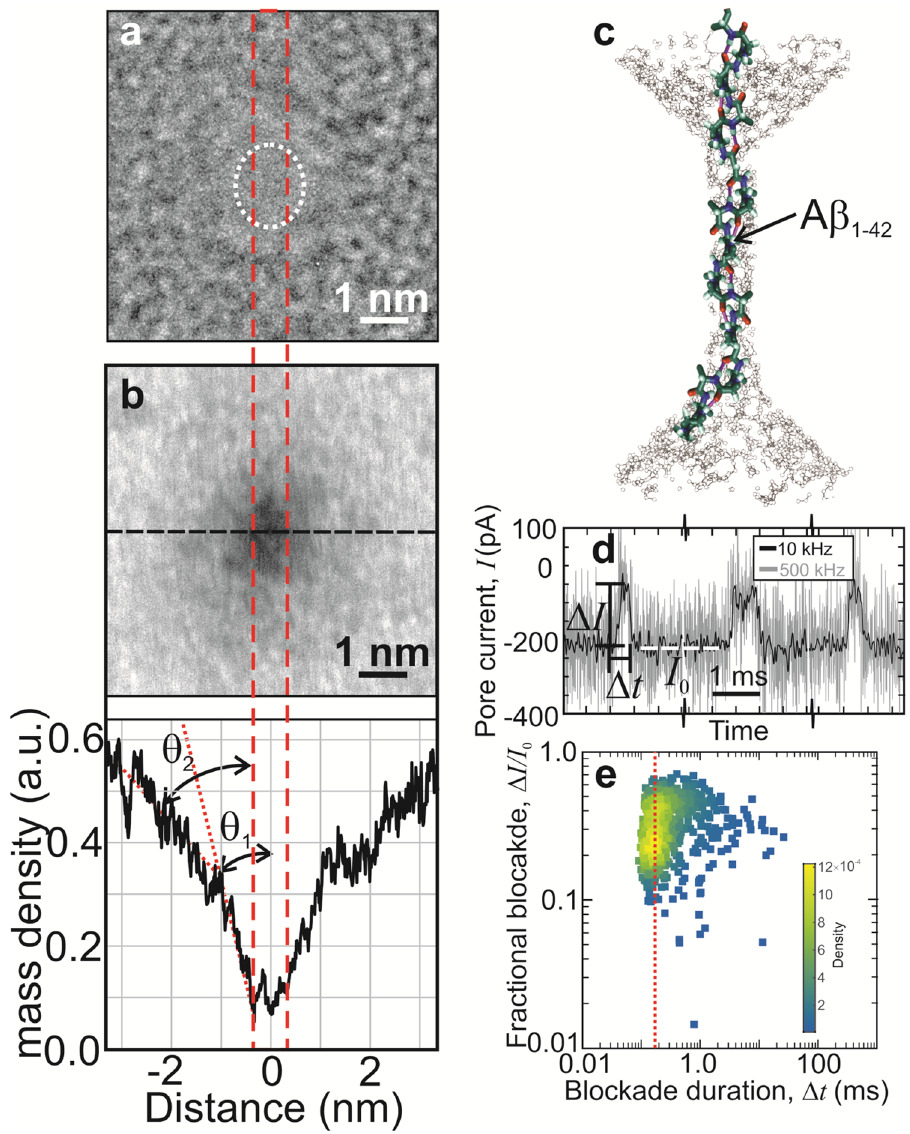
Figure 1. Improved read resolution and fidelity using a sub-nanopore through a thin laminated a- Si membrane. ( a ) A TEM image is shown in vacuo of a nanopore immediately after sputtering through a nominally 5 nm thick a- Si membrane. The cross-section of the pristine pore was estimated from the shot noise associated with electron transmission through the pore to be about 1.0 × 1.5 nm 2 (dotted circle). ( b , top) An HAADF-STEM image, acquired with an aberration-corrected microscope is shown of the pore in ( a ) after exposure to the ambient. ( b , bottom) The profile of the mass-density under the probe beam is shown taken along the dashed (horizontal) line in ( d , top). The cross-section shrunk to about 0.65 nm × 0.87 nm, indicative of the growth of a native oxide in the pore waist. ( c ) A schematic representation is shown depicting a translocation of Aβ 1–42 impelled by an electric force through a sub-nanopore. The actual pore is ghosted in the figure; only the peptide is represented. ( d ) Current traces (negative raw current) are shown that illustrate the distribution of the duration of the blockade currents associated with translocations of single molecules of Aβ 1–42 through a sub-nanopore spanning an a- Si membrane at 0.6 V. The pore current was amplified over a > 75 kHz bandwidth and sampled at 500 kHz (gray line) to detect each residue in the peptide in a ∆ t = 170 μs blockade. Another version of the same data, filtered with a 10 kHz eight-pole Bessel filter (black line), is also shown. The definition of the blockade current, ∆ I , the blockade duration, ∆ t , and the open pore current, I 0 , are indicated. Higher current (negative raw current) values correspond to larger blockade currents. ( e ) A heat map is shown that illustrates the distribution of fractional blockades relative to the open pore current (Δ I/I 0 ) versus the blockade duration (∆ t ) associated with single denatured Aβ 1–42 molecules translocating through a sub-nanopore acquired at 0.6 V. The red dotted line shows the position of 170